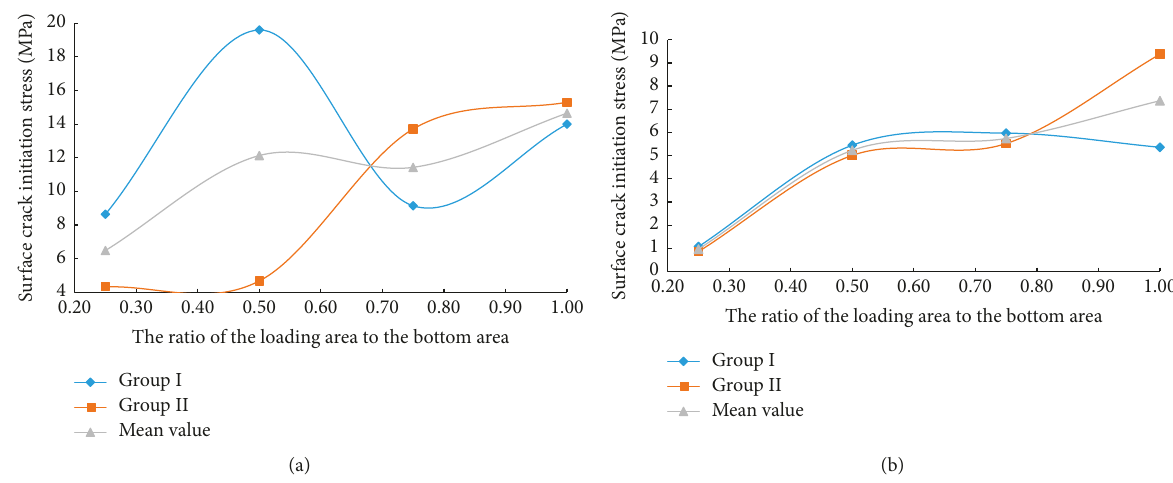
Figure 11: Curve of crack initiation stress of two kinds of samples. (a) Coal samples; (b) briquette Samples.